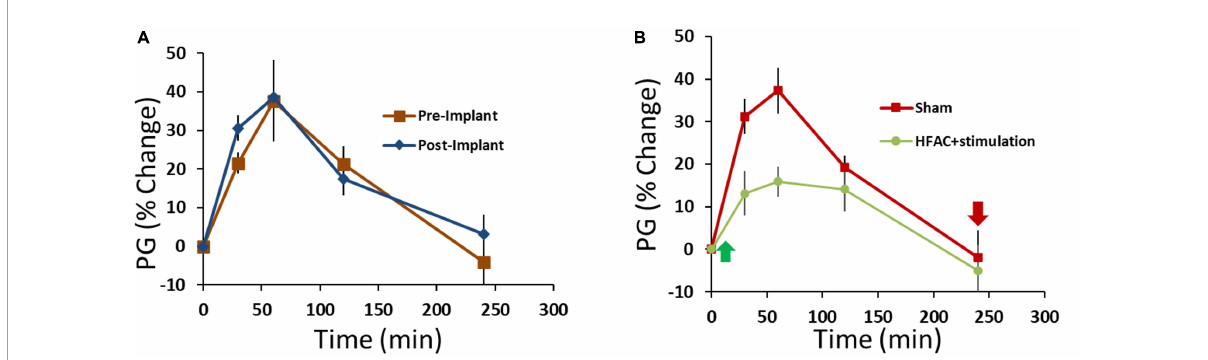
FIGURE9 Application of high frequency alternating current (HFAC) to the hepatic branch of the vagus nerve with simultaneous stimulation of the celiac branch of the vagus nerve increased performance on an oral glucose tolerance test (OGTT) compared to pre-device initiation OGTTs in Alloxan treated swine. (A) Results from an OGTT conducted prior to implant of the device and following the implant of device were similar; suggesting that the implant itself did not change glycemic control. n = 3 swine. (B) Application of HFAC + stimulation 5 min following the initiation of the OGTT significantly improved performance on the OGTT in Alloxan treated swine n = 6 swine. Green arrow depicts when HFAC + stimulation was turned on and red arrow depicts when HFAC + stimulation was tuned off. n = 6 swine. Error bars are